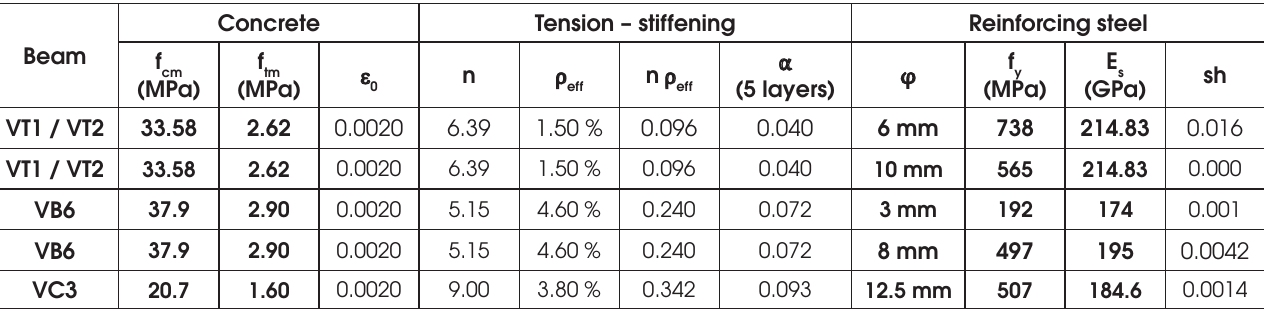
Material properties used in numerical analysis of beams VT1/VT2/VB6/VC3 (experimental values in bold, calculated or estimated values without bold)